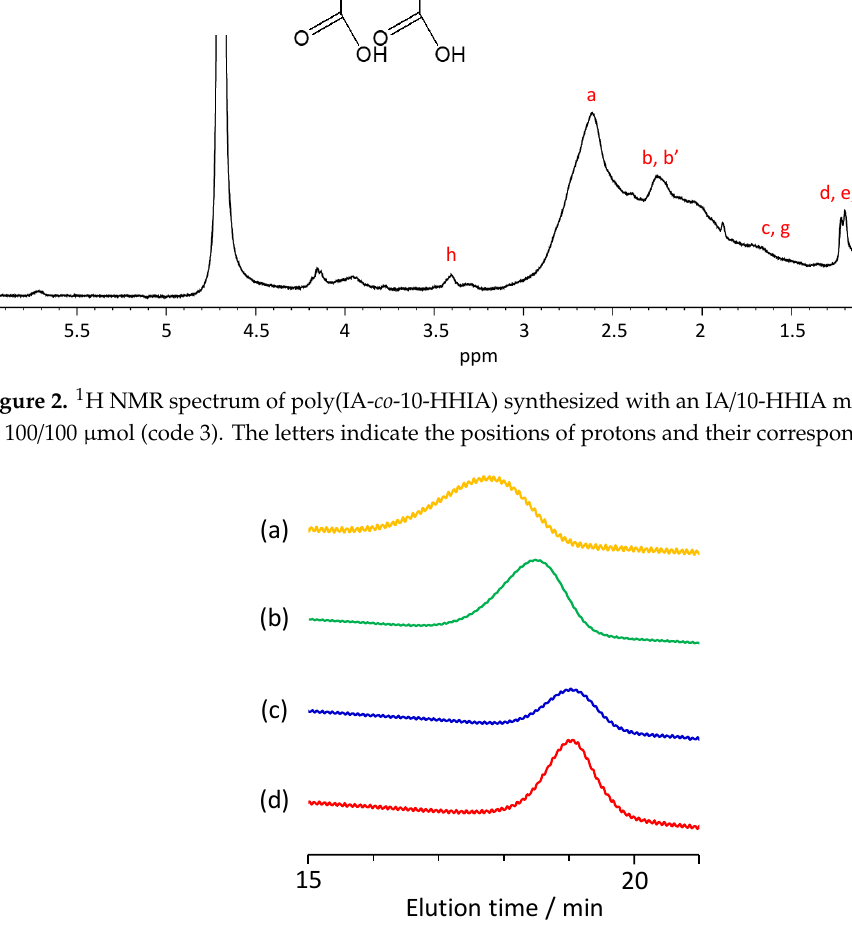
Fig. 4 Aso et al. Figure 4. TGA thermograms of poly(IA- co -10-HHIA)s. ( a ) Code 1, ( b ) code 2, ( c ) code 3, ( d ) code 4. Figure 5 shows FT-IR spectra of poly(IA) and a representative poly(IA- co -10-HHIA) copolymer before and after heating at 200 °C for 18 h. The non-heated poly(IA) has the characteristic peaks at 2800–3400 cm −1 , 1707 cm −1 , 1639 cm −1 , 1411 cm −1 , 1193 cm −1 , and 908 cm −1 assigned to a broad -OH stretching, the carboxylic acid (C=O) stretching, asymmetric C=O stretching of carboxylate anion, symmetric C=O stretching of carboxylate anion, C-O-H in-plane bending interactions, C-O stretching dimer, and O-H out-of-plane bending, respectively, according to the FT-IR spectrum of